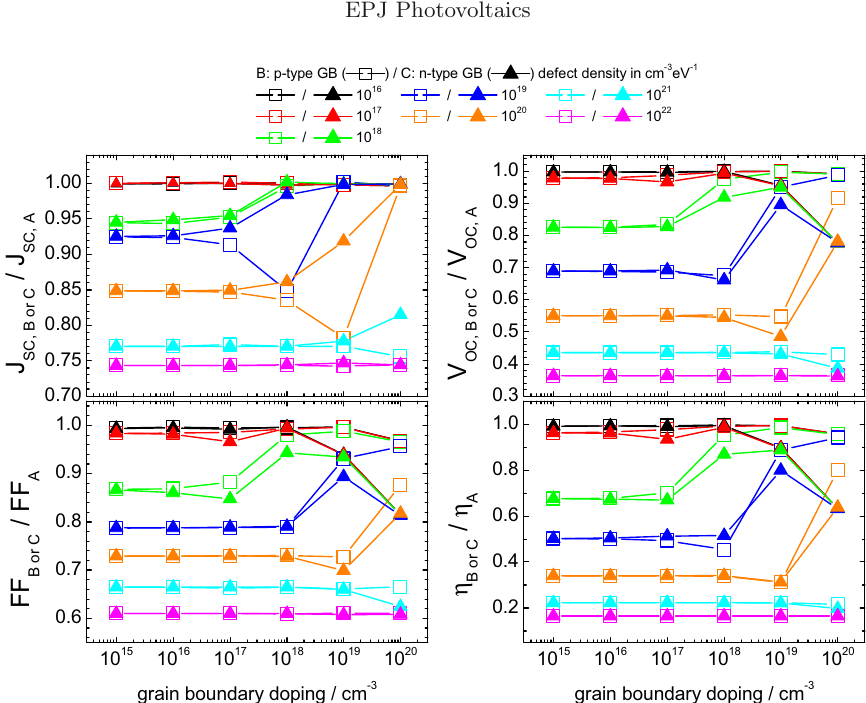
Fig. 3. Simulations of the solar cell parameters of the structure B (with p -type GB) and C (with n -type GB) normalized to the corresponding solar cell parameters of structure A (without any GB, reference cell) J SC , B or C /J SC , A , V OC , B or C /V OC , A , FF B or C / FF A and η B or C /η A for varying GB doping concentration (abscissae) and for different GB defect densities (symbol slopes).